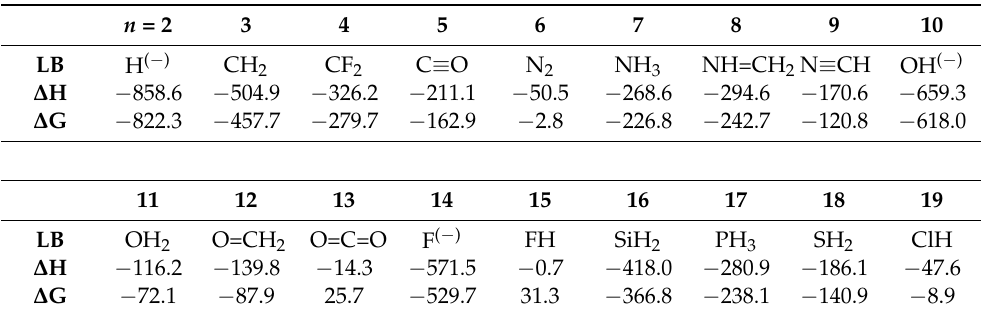
Table 1. Enthalpy ( ∆ H) and free energy ( ∆ G) of formation for complexes ( 1 : n ), n = 2 – 19 , in kJ · mol − 1 . LB: Lewis base.